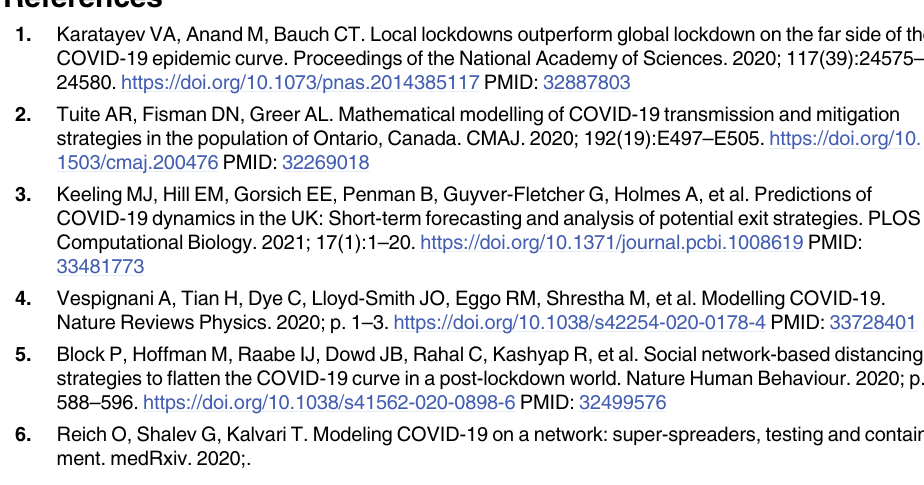
oured in yellow. The plots show that as λ increases, the initial mass spread further away